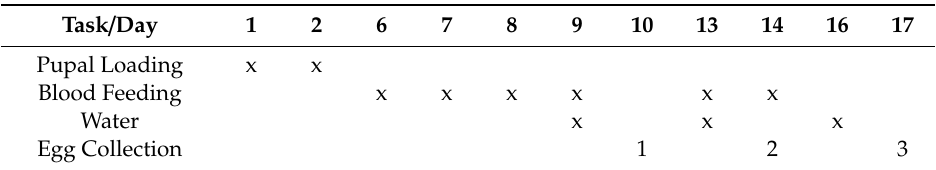
Figure 2. External view of the new mass-rearing cage prototype (90 (L) × 90 (H) × 20 (W) cm) ( A ) and the reference Anopheles mass-rearing cage (200 (L) × 100 (H) × 20 (W) cm) structure ( B , C ). The new mass-rearing cage ( D ) and the reference Anopheles mass-rearing cage ( E ) were covered with black cloth to enhance blood feeding. Table 2. Rearing procedures for Anopheles arabiensis